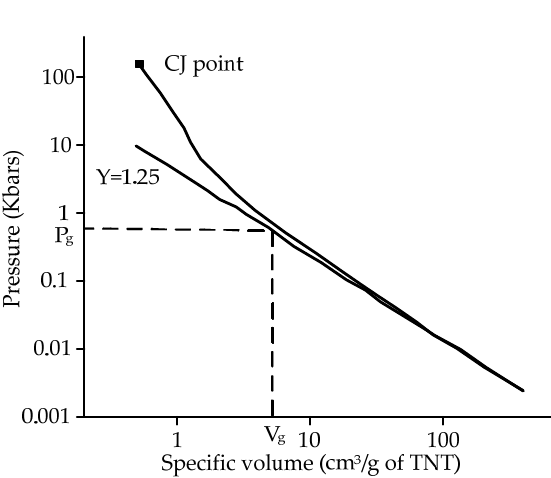
Figure 7. Cole calculation for TNT on the logarithmic plot.